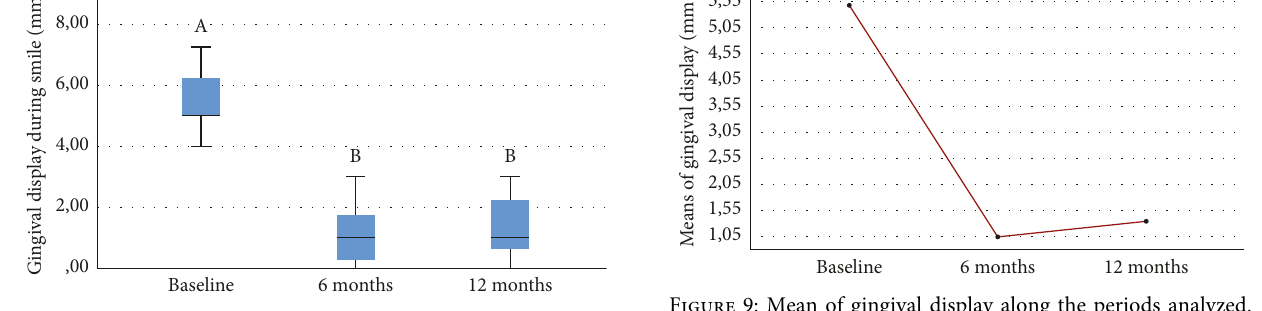
Figure 8: Boxplot of the gingival exposure for baseline and 6 and 12 months after treatment.